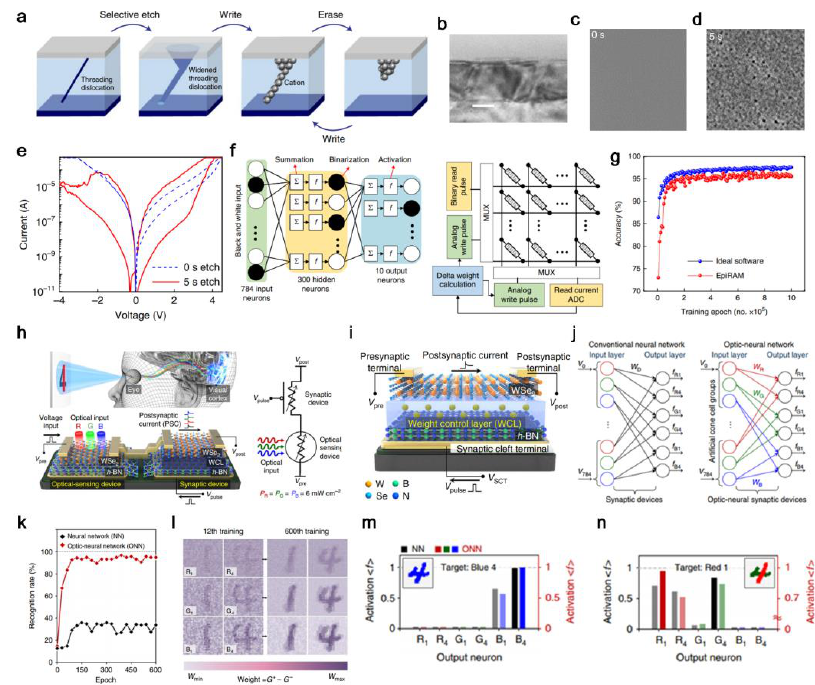
Figure 8. Reliable resistive switching based on dislocation engineering. ( a ) Operation principle of epitaxially grown SiGe-based random-access memory (epiRAM): selective etch for widening the threading dislocation for facile cation migration (filament formation). ( b ) Cross-sectional scanning electron microscope (SEM) image of the epiRAM showing dislocated SiGe films. Surface SEM image of epiRAM ( c ) before etching and ( d ) after 5 s of etching. ( e ) Corresponding resistive switching characteristics after 0 s (blue) and 5 s (red) of etching. Neural network demonstration using a memristor array. ( f ) Multi-layer perceptron (MLP) neural network using epiRAM for signal recognition (black and white input) and circuit diagram using epiRAM array-embedded hardware with peripheral circuit (right part). ( g ) Accuracy achieved using the training epoch by ideal software (blue) and epiRAM array-based hardware (red). Artificial optic-neural synaptic device for color-mixed pattern recognition task; adapted with permission from ref. [128], copyright 2018 Springer Nature. ( h ) Schematic of the human optic nerve system (visual cortex and eye) and h-BN/WSe 2 (optical sensing device) integrated with WSe 2 /WCL/h-BN (synaptic device). ( i ) Detailed structure of synaptic devices comprising WSe2 and a weight control layer (WCL) between the pre- and post-synaptic terminals. ( j ) Optic neural network for recognition of 28 × 28 RGB-colored images. ( k ) Recognition rate comparison between a basic neural network (black) and an optic neural network (red). ( l ) Weight-mapped images after 12th (left) and 600th (right) training epoch. Activation values for each output neuron for ( m ) single-colored image (blue) and ( n ) color-mixed image (red and green) after the 600th training epoch; adapted with permission from ref. [129], copyright 2018 Springer Nature.